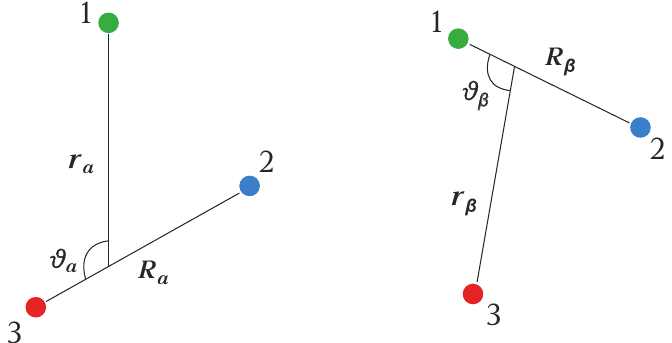
Figure 6. The set of Jacobi coordinates ( R α , r α , ϑ α ) is convenient for describing the asymptotic states 1 + ( 23 ) njK , whereas another set of Jacobi coordinates ( R β , r β , ϑ β ) is convenient for describing the asymptotic states ( 12 ) n (cid:48) j (cid:48) K (cid:48) +